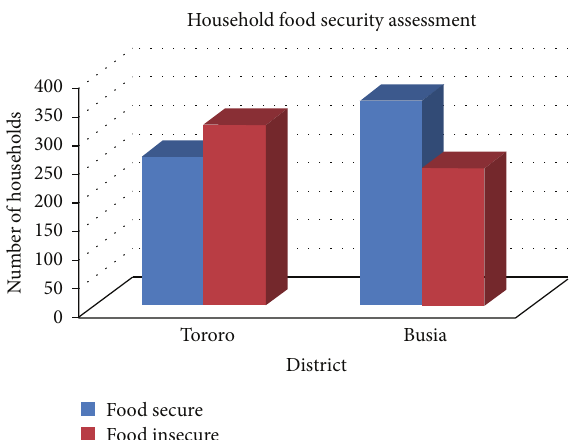
Figure 1: Household food security assessment for Tororo and Busia districts.